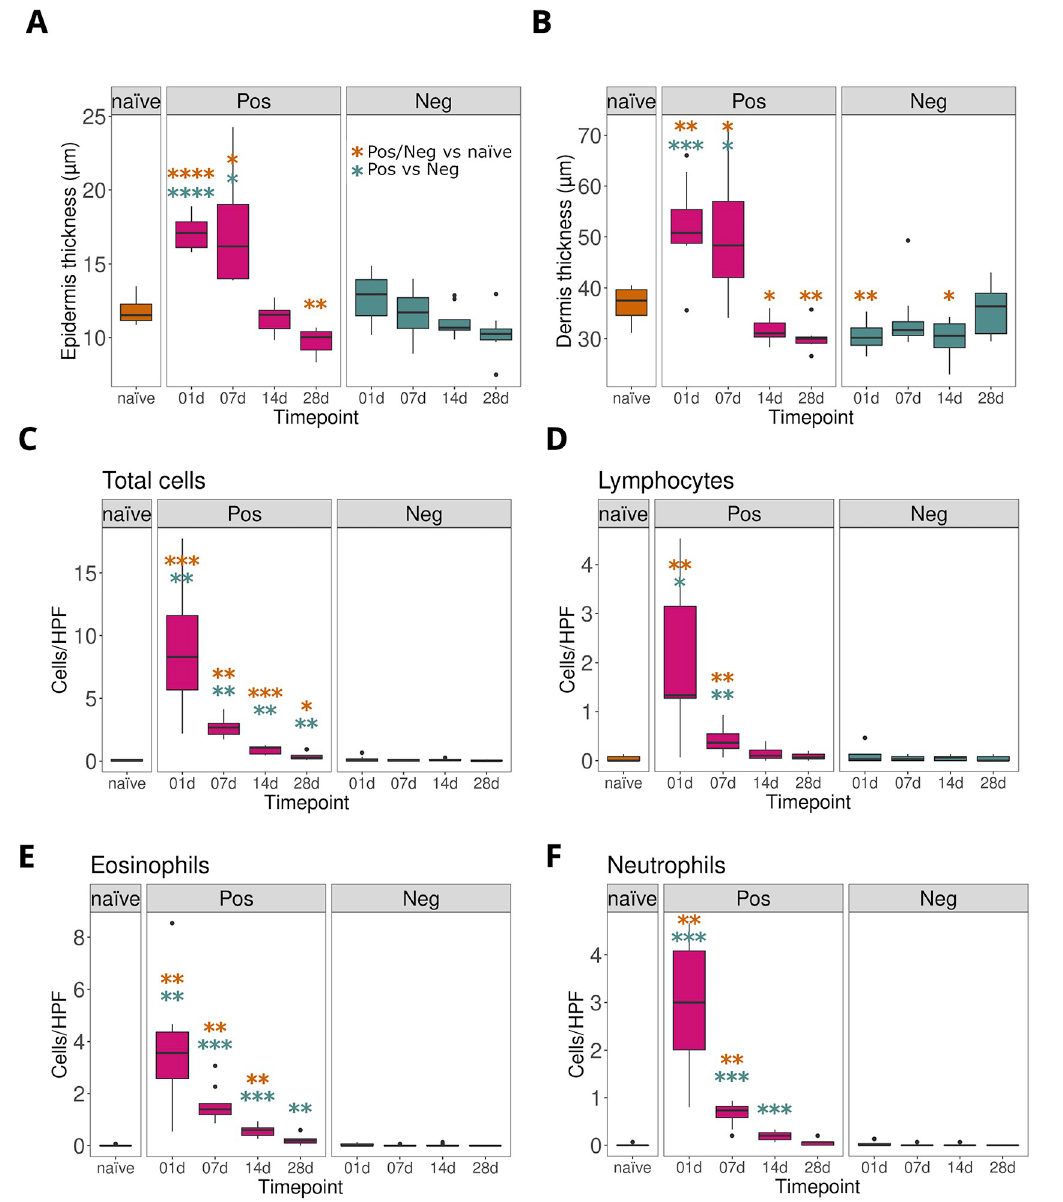
Fig 1. Repeated exposure to oxazolone induces skin thickening and recruitment of immune cells. OXA-induced inflammation was studied by measuring thickness of epidermis (A) and dermis (B) in H&E-stained skin sections. The number of total cells (C), lymphocytes (D), eosinophils (E) and neutrophils (F) were counted from H&E-stained skin tissue under a light microscope at 1000x magnification. P values for epidermis and dermis were calculated with Brown-Forsythe and Welch ANOVA and Dunnett’s T3 multiple comparison tests and P values for immune cells were calculated with Kruskal-Wallis and Dunn’s multiple comparison tests. Yellow significance stars indicate the test between na ï ve and positive or na ï ve and negative, and blue significance stars between negative and positive group. P values: � < 0.05. �� < 0.01, ��� < 0.001, ���� <